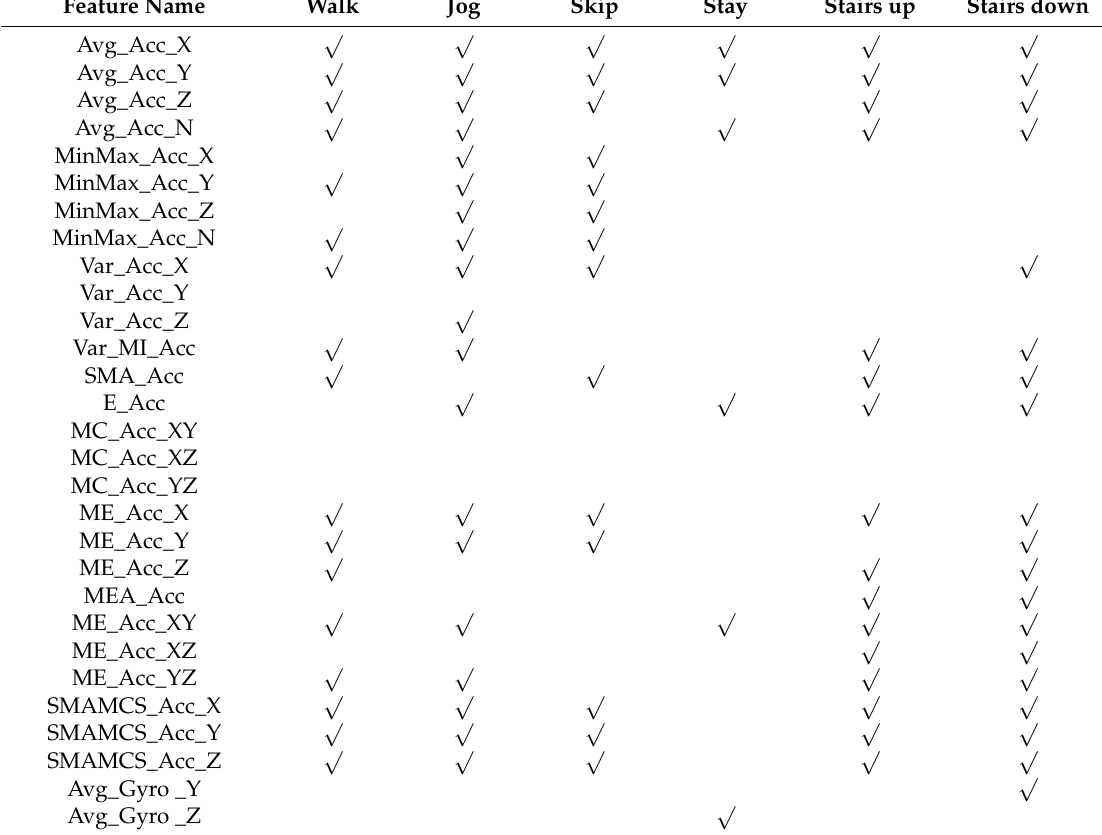
Table A4. List of selected features due to the different activity datasets in the balanced dataset